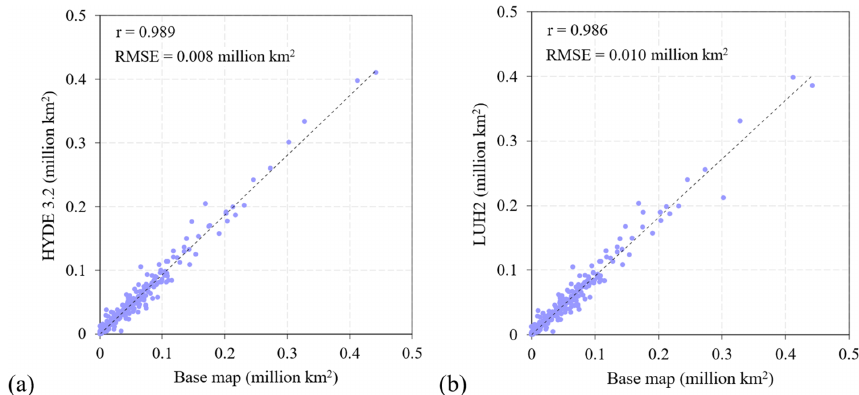
Figure 12. Comparison of cropland area at the downscaling region level between the base map and (a) HYDE 3.2 in 2010CE and (b) LUH2 in 2010CE. The black lines are the linear regression lines.